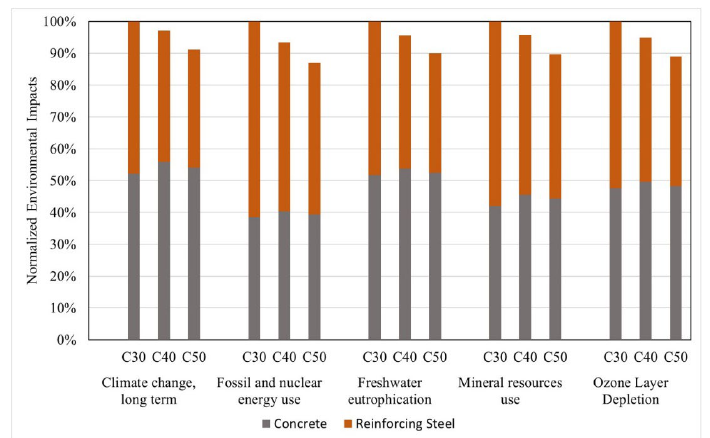
Figure 6. Impacts of RC columns detailed by concrete and reinforcing steel